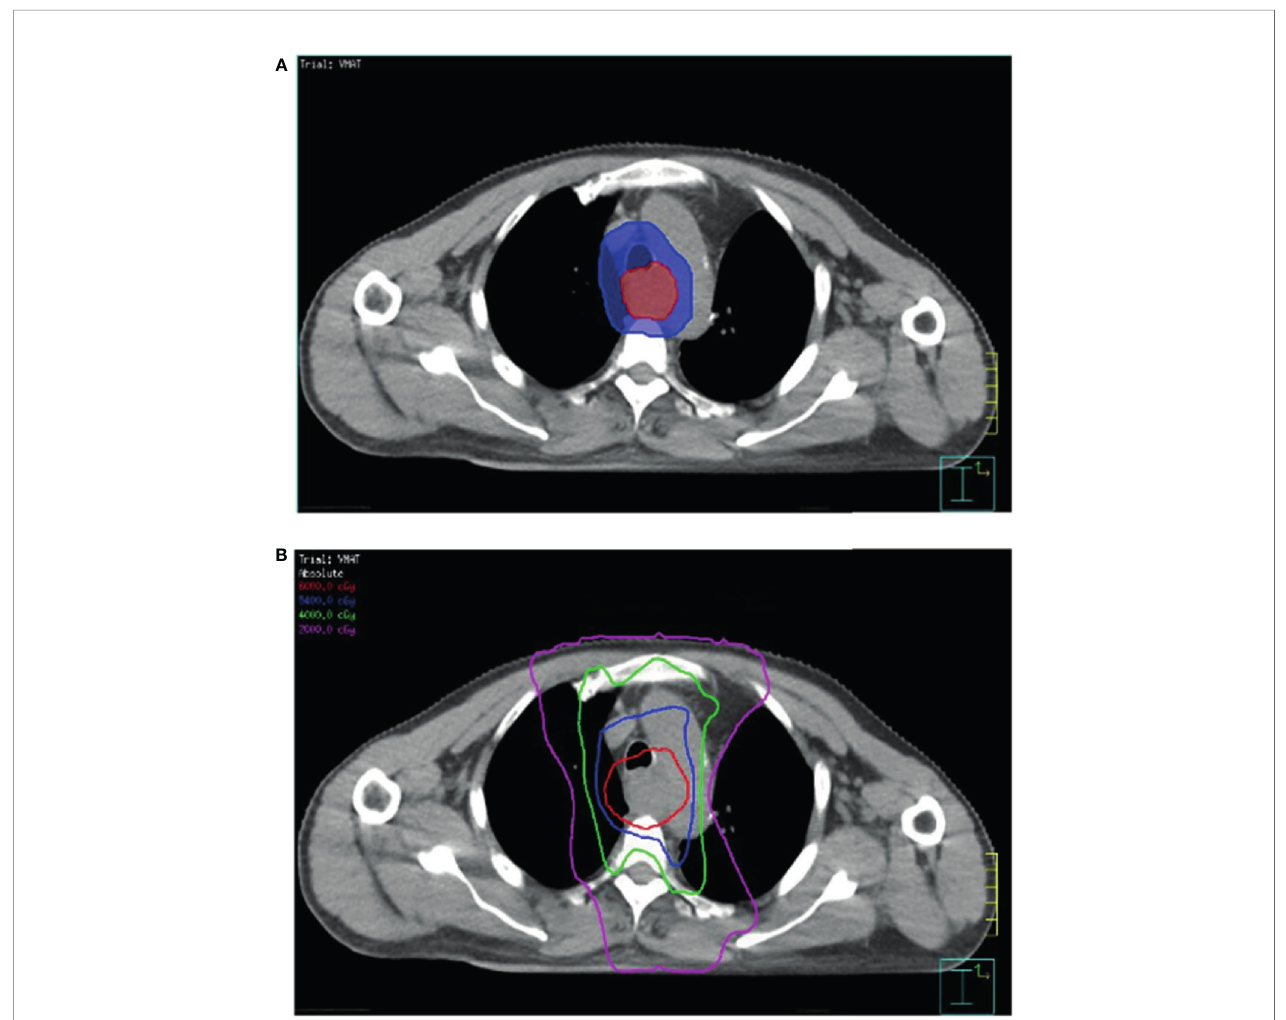
FIGURE 1 | Computed tomography simulation image of radiotherapy planning. (A) Simultaneous integrated boost intensity-modulated radiotherapy used in patients with ESCC. (B) Planned target volume (blue area) is an expansion of the gross tumor volume (red area). The isodose lines represent the total doses of 60 Gy (red), 54 Gy (blue), 40 Gy (green), and 20 Gy